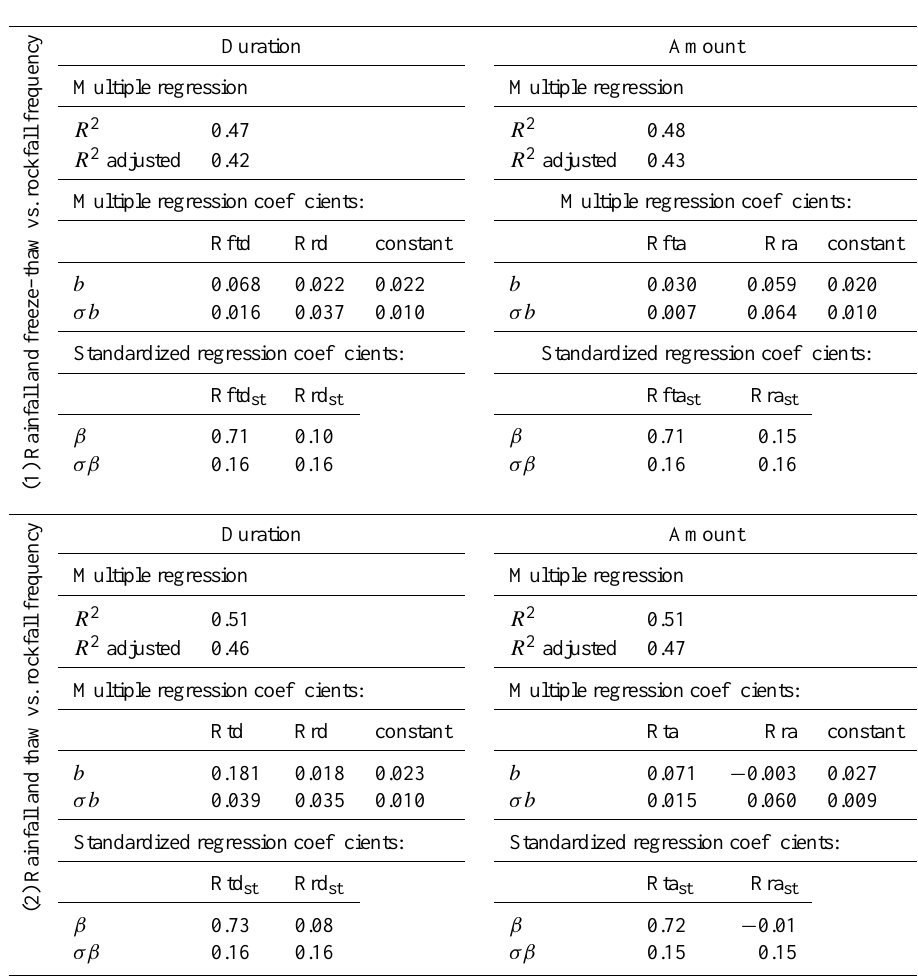
Table 4. Multiple linear regression values, considering rainfall and freeze–thaw, and rainfall and thaw only.